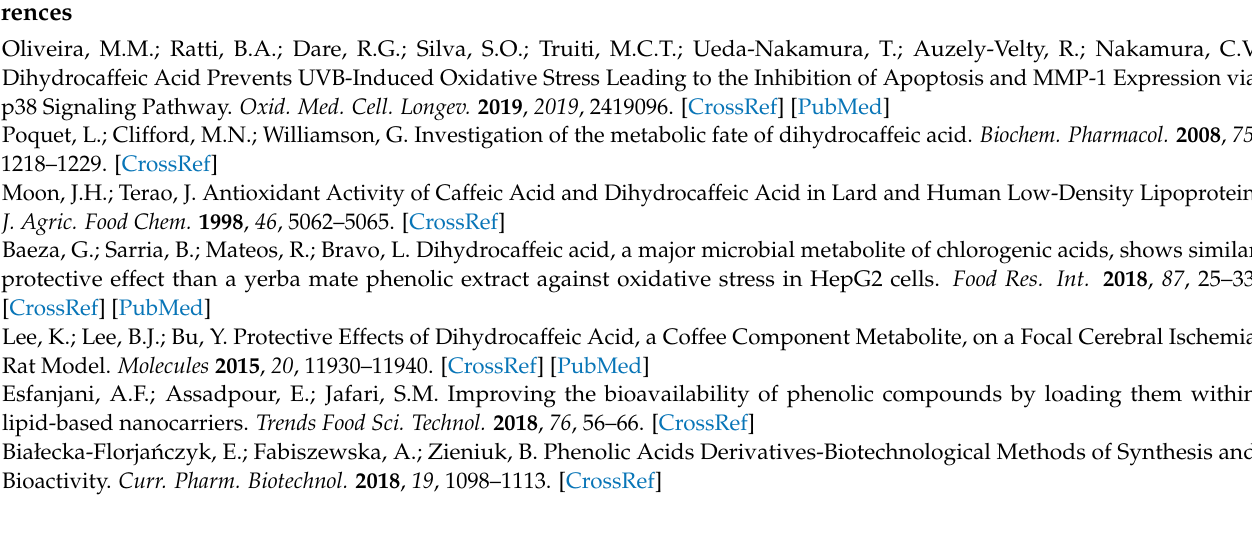
( d ) mucoricin; Table S1: The estimated target-template alignment/predicted model quality